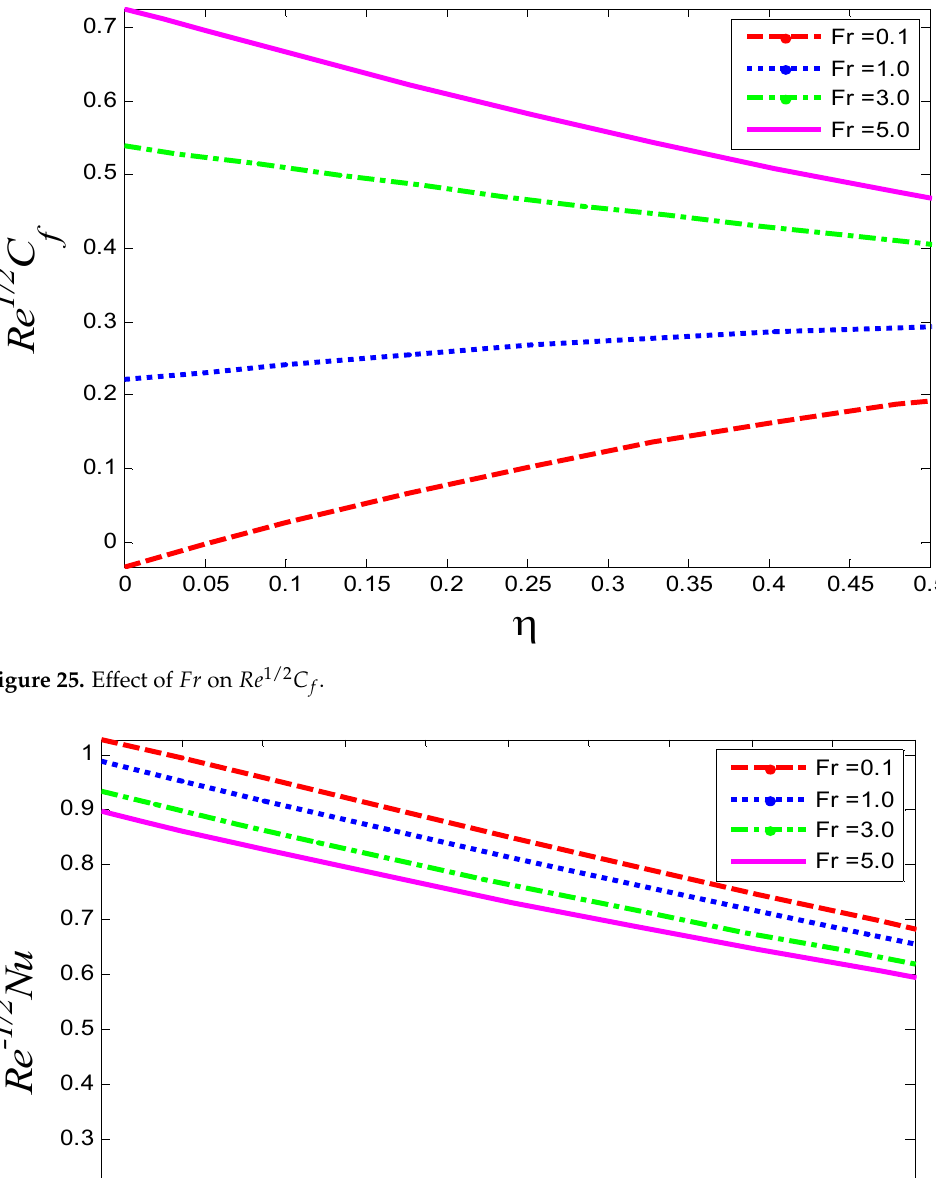
Figure 24. Effect of 𝐾 ∗ on r 𝑅𝑒 (cid:2879)(cid:2869)/(cid:2870) 𝑆ℎ .